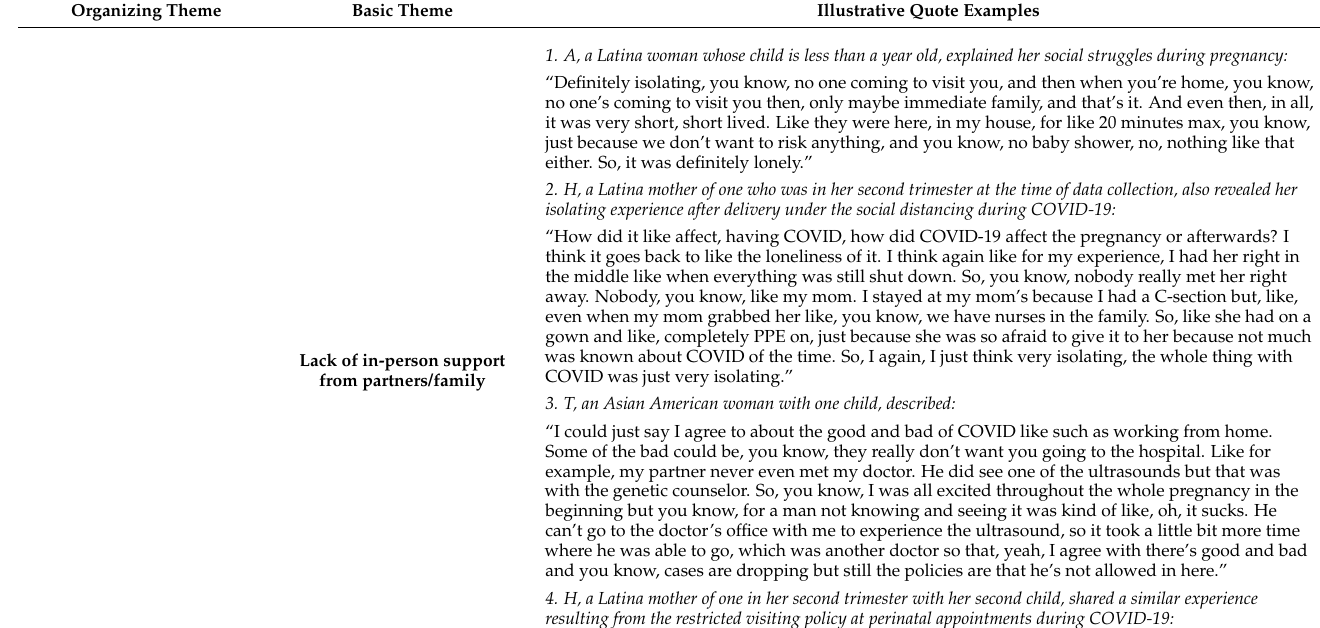
Table 2. Organizing Themes and Basic Themes with Illustrative